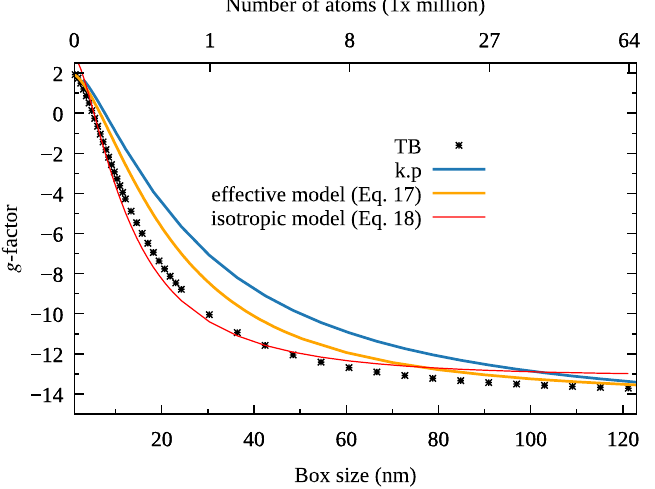
Figure 2. (Color online) The electron (conduction band) g-factor in the same-anion-terminated InAs cubic box of T d symmetry as a function of box size, and calculated using three different approaches. Corresponding number of atoms used in atomistic tight-binding calculations is shown in the upper axis. See text for